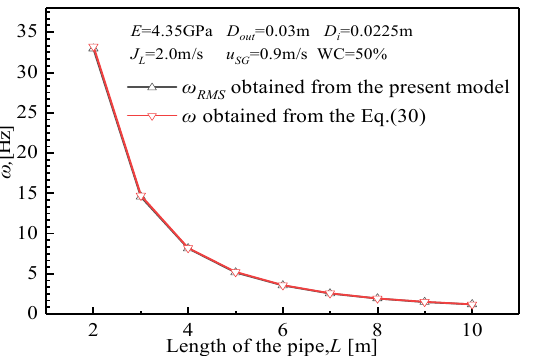
Figure 5. Comparison between natural frequencies determined from the present model and Equa- tion (30).